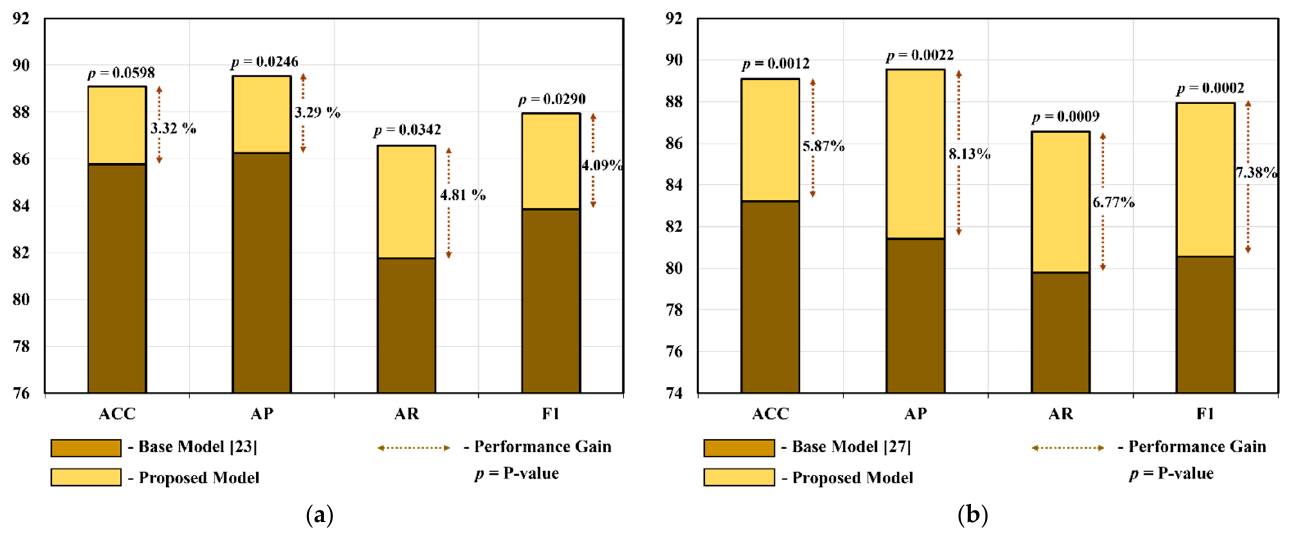
between the base model presented in [23] and the proposed model ( p -values), as well as the perfor- mance gain obtained using the proposed model compared to that of the base model [23], and ( b ) difference between the base model presented in [27] and the proposed model ( p -values), along with the performance gain obtained using the proposed model compared to that of the base model [27].